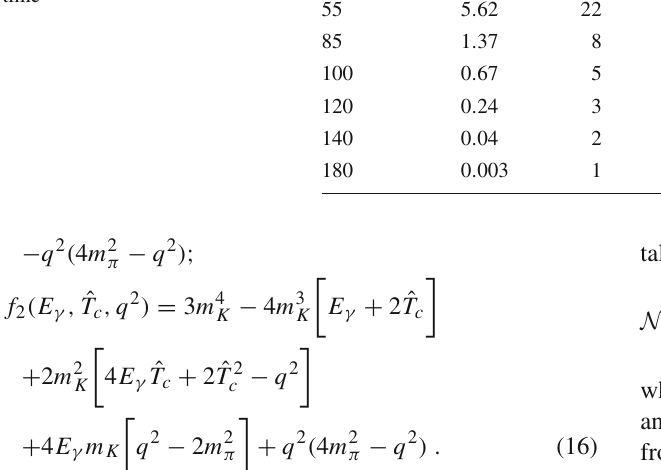
the Bremsstrahlung and the relative weight of the electric and electric interference terms for different cuts in q , starting at q min (first row) and ending at 180 MeV. To highlight the role of the different counterterms, the last columns show how the interference term changes when they are switched off one at